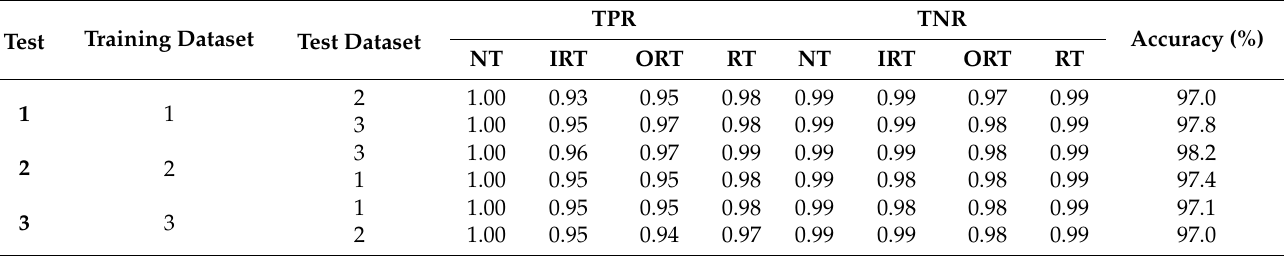
Figure 20. Summary plot for the test dataset on the SHAP values of ( a ) model 1, ( b ) model 2, and ( c ) model 3. Table 10. Diagnostic performance of the invariant